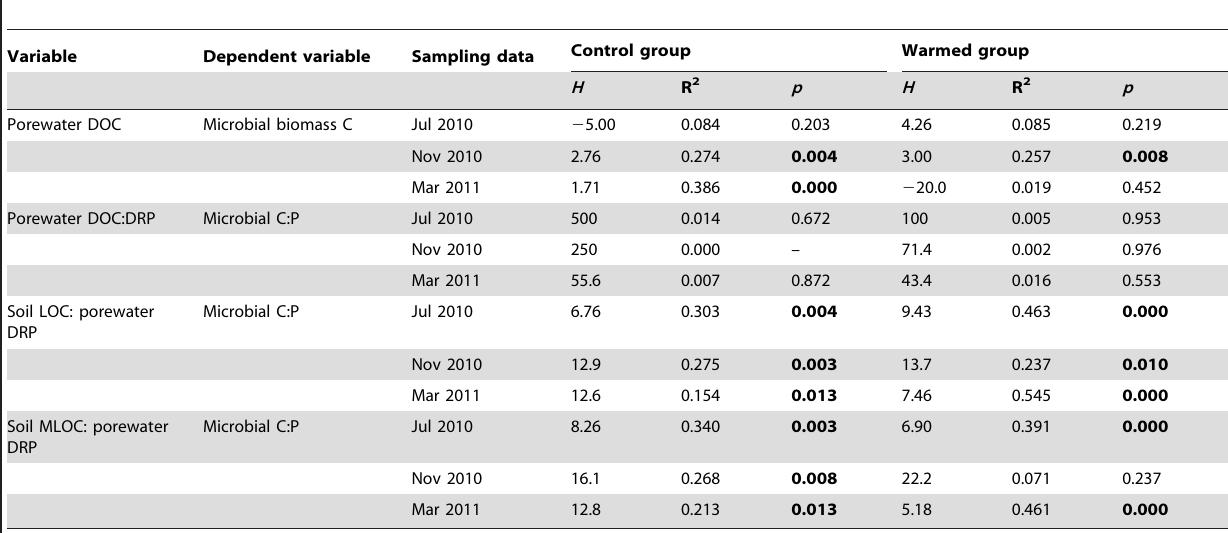
Table 4. Homeostatic regulation coefficient ( H ) in soils collected from wetland columns in the microcosm experiment (Control: ambient temperature; Warmed: ambient temperature + 5 u